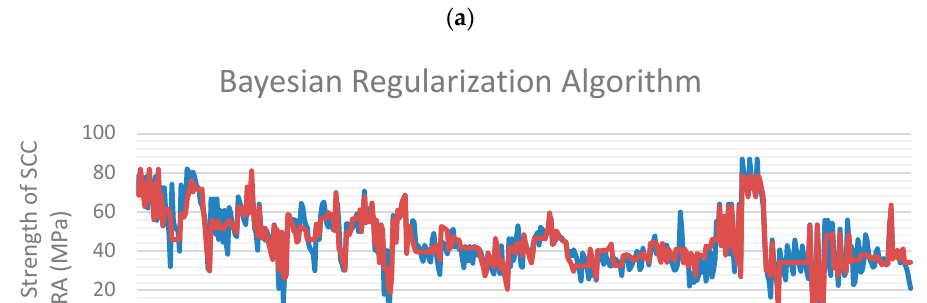
the LM, BR, and SCG algorithms, respectively. The red line on the y -axis represents pro-